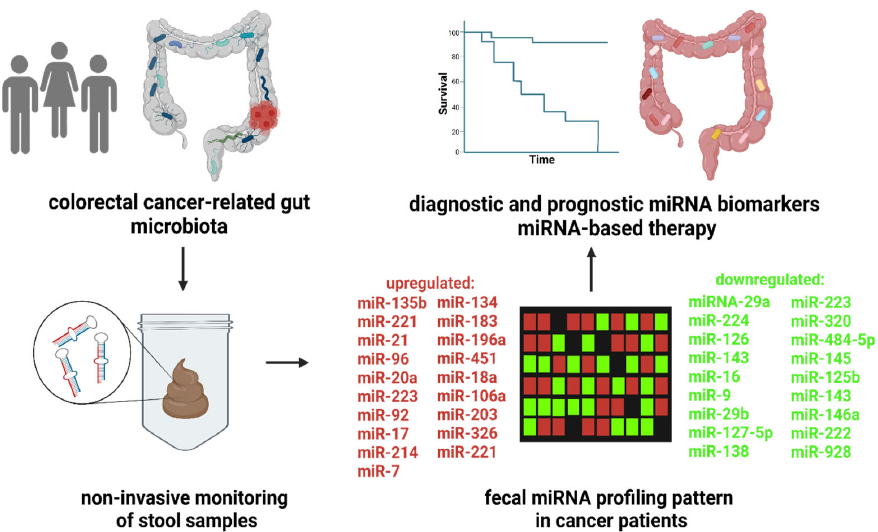
Figure 1. Fecal miRNA profiling as a diagnostic and prognostic tool in colorectal cancer. The clinical studies showed numerous up- or downregulated miRNA in CRC patients compared to control subjects. Moreover, the changes in fecal miRNA levels are correlated with disease prognosis. Thus, high-throughput screening of fecal miRNA profile represents a potential, noninvasive trend in patient care. The use of personalized miRNA-based therapy might lead to improvements in survival and outcomes for cancer patients. The figure was created with BioRender.com (accessed on 16 November